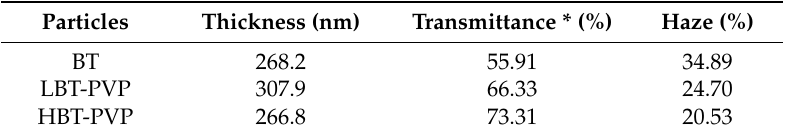
Table 2. Properties of BT, LBT-PVP, and HBT-PVP thin films coated on PET substrates. Particle concentration in the EtOH coating slurry is 5 wt %.